Question: What does this figure show? Answer in one sentence.
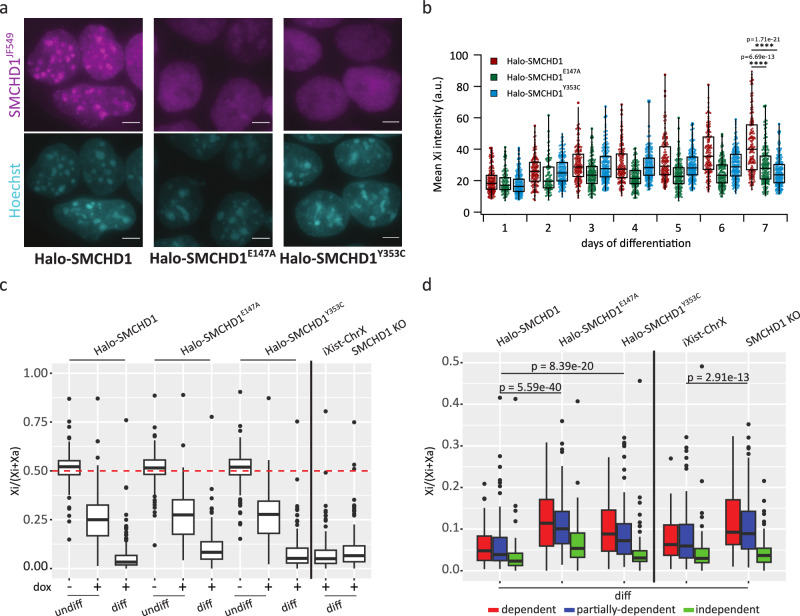
Answer: SMCHD1 GHKL ATPase mutations abrogate Xi localisation and silencing function. a Representative live-cell images of indicated mESCs undifferentiated, kept for 24 h with doxycyline. Images are maximum-intensity projections. Scale bar − 5 µm. b Quantification of SMCHD1 signal underlying CIZ1 domains in indicated cell lines during a 7-day differentiation timecourse. Each dot represents a single cell, n = 102–206 (day 7 – Halo-SMCHD1 (151), E147A (185), Y353C (194)). Boxplots: centre lines indicate the median, box limits indicate the first and third quartiles and whiskers extend to min/max data points. Statistical analysis was by two-sided unpaired t-test. c Box plot showing allelic ChrRNA-seq analysis of transcription of X-linked genes ( n = 184) in indicated cell lines with and without doxycycline (dox) and 7 day differentiation. The boxes represent one (undiff conditions) or an average from two (diff E147A, Y353C, iXist-ChrX, SMCHD1 KO) or three (Halo-SMCHD1) replicates d Box plot showing allelic ChrRNA-seq analysis of transcription of X-linked genes ( n = 184) in mESC lines which were differentiated for 7 days, with genes split into three categories according to their dependency on SMCHD1 for silencing 13 . An average of two (E147A, Y353C, iXist-ChrX, SMCHD1 KO) or three (Halo-SMCHD1) replicates was used for this plot. Statistical analysis – two-sided paired t test. undiff = undifferentiated, diff = differentiated. Boxplots ( c , d ) centre lines indicate the median, box limits indicate the first and third quartiles and whiskers indicate 1.5× the interquartile range (IQR). Source data are provided as a Source Data file.